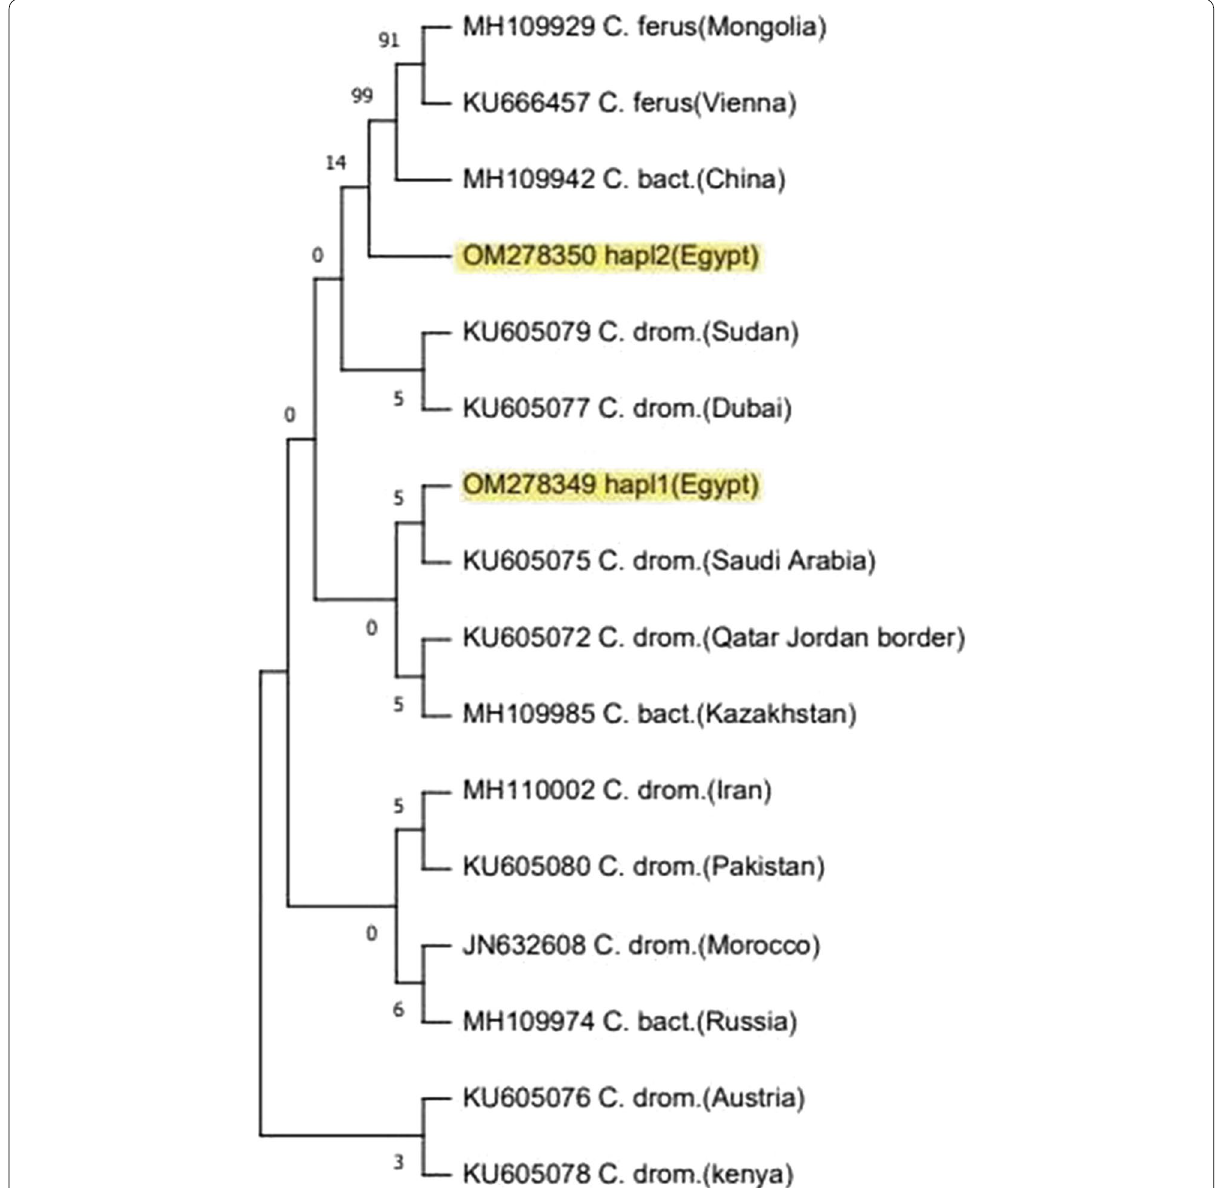
Fig. 5 Phylogeny tree constructed by maximum likelihood approach among studied camel populations and other sequences submitted in GenBank/NCBI MEGA 11 using the Kimura two-parameter model with 1000 bootstrap